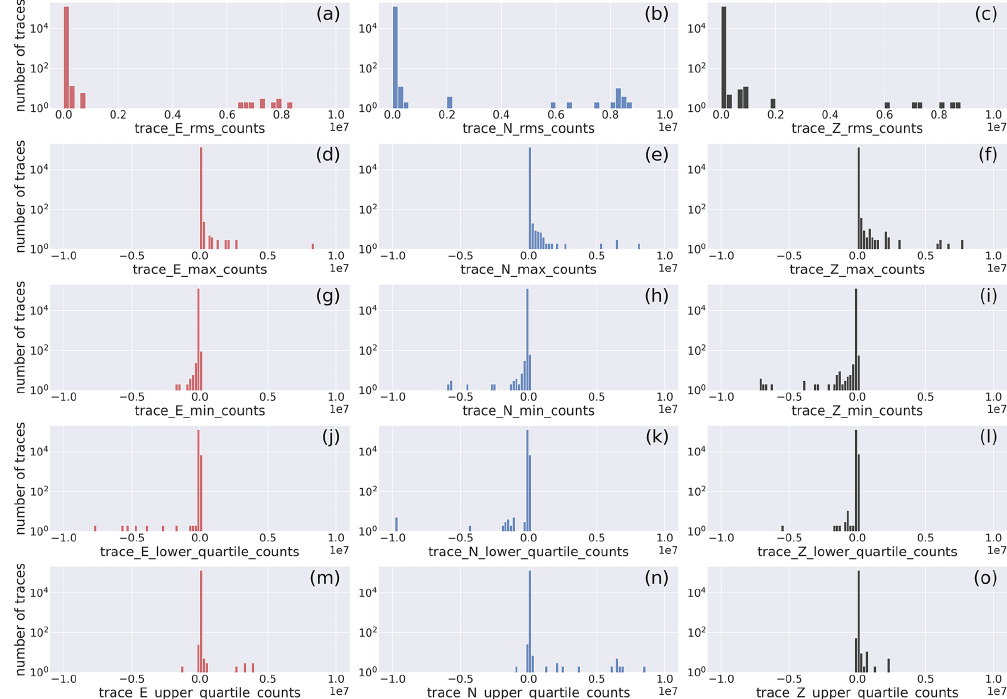
Figure D6. Histogram of the distribution of noise quality control metadata: rms, min, max, and first and third quartile. The width of the bins is 2 × 10 5 ; axes are labeled according to the metadata listed in Table